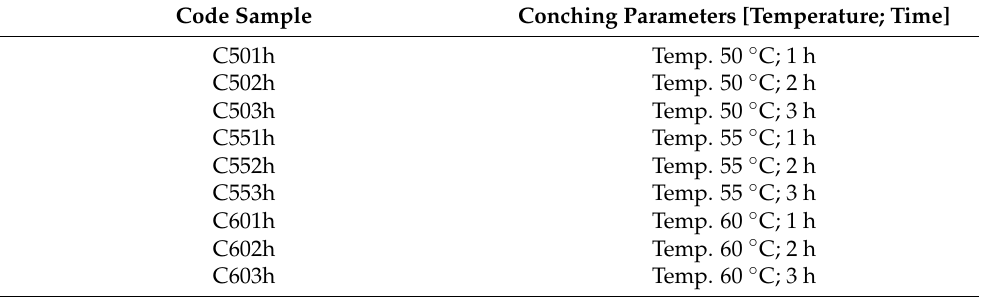
Table 5. Designation (codes) of CMM and conching